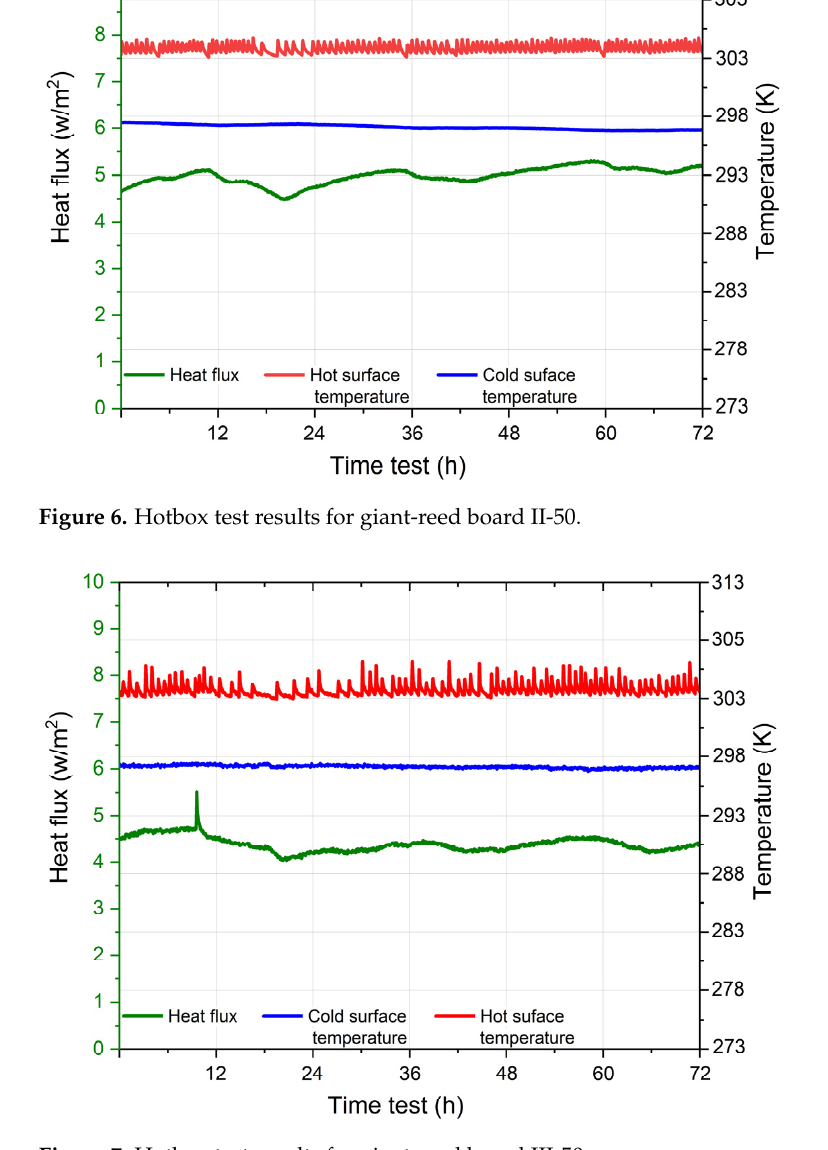
Figure 7. Hotbox test results for giant-reed board III-50.